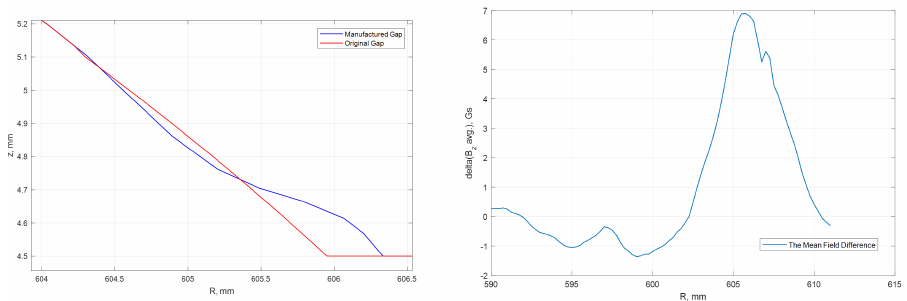
Figure 2. Left: The designed geometry of the gap compared to the manufactured one. Right: The amount of the reduction of the mean field versus the